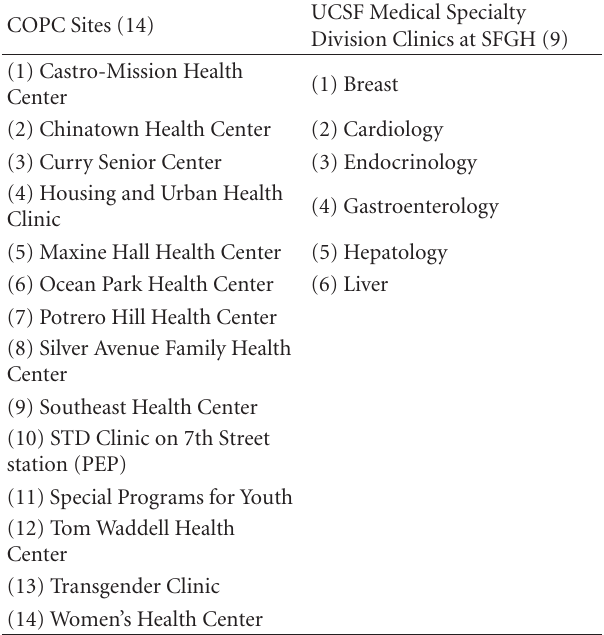
Table 3: Study sites/population of